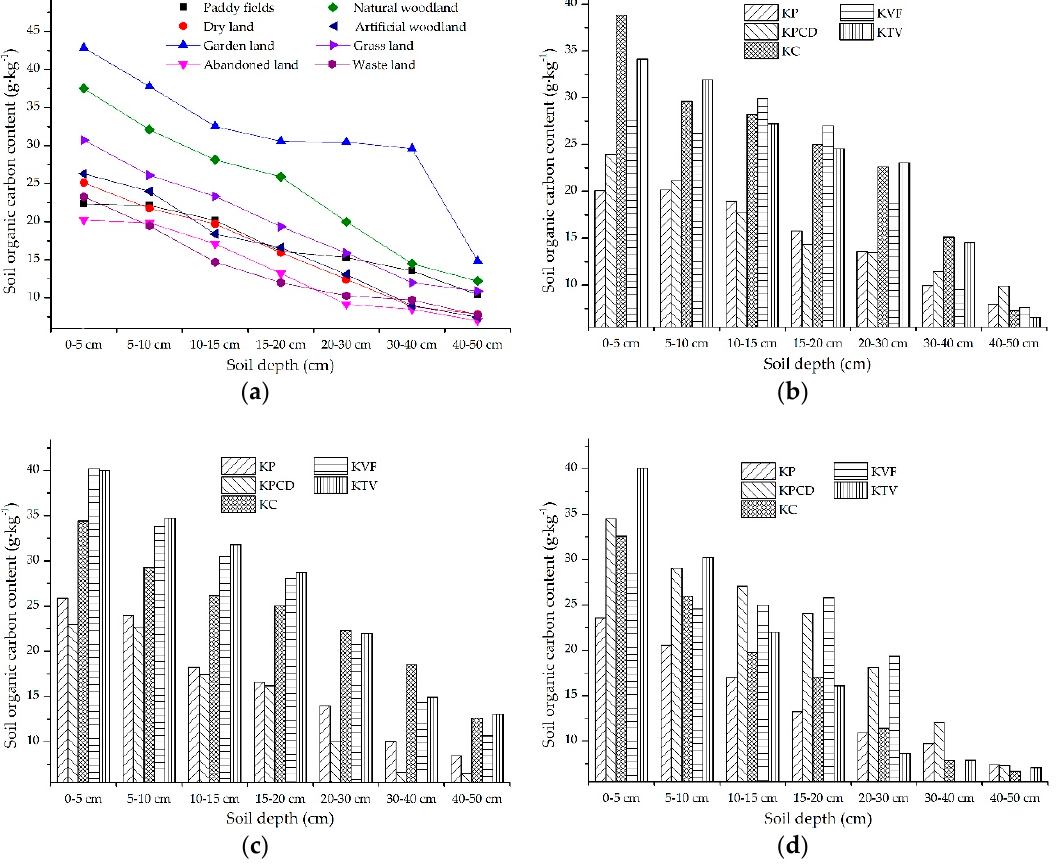
Figure 6. The spatial distribution characteristics of the soil organic carbon (SOC) content under different land uses: ( a ) shows the content of SOC under different land uses; ( b ), ( c ) and ( d ) represent the SOC content in topsoil in different karst landforms in agricultural land, forestry land and unused land, respectively.